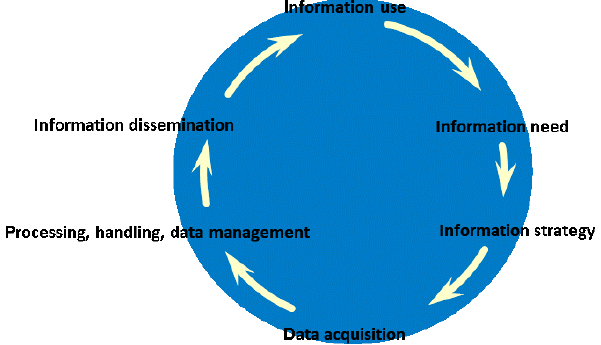
Figure 1. Information cycle for optimum decision